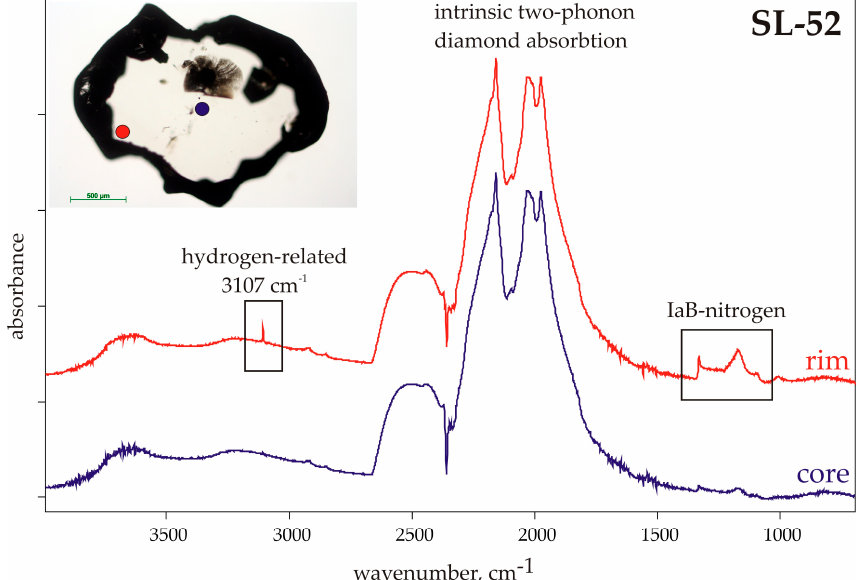
Figure 5. Representative Fourier transform infra-red (FTIR) spectra of core (dark-blue) and rim (red) of diamond SL-52. The locations of each spectra are highlighted on the transmitted light image of the polished plate (left corner).